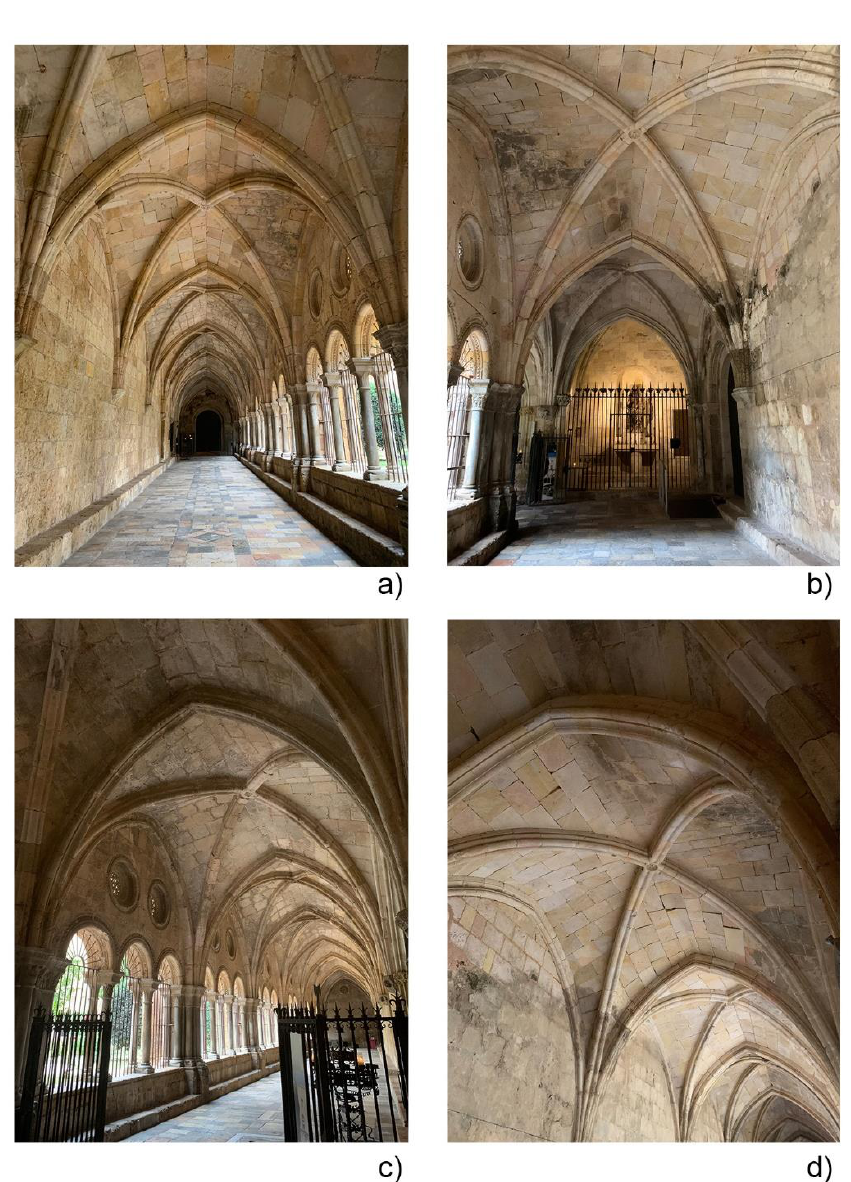
Figure 2. View of the northern corner: ( a ) west gallery view, ( b ) north gallery view, ( c ) east gallery view from the corner, ( d ) close view of the vault V4.